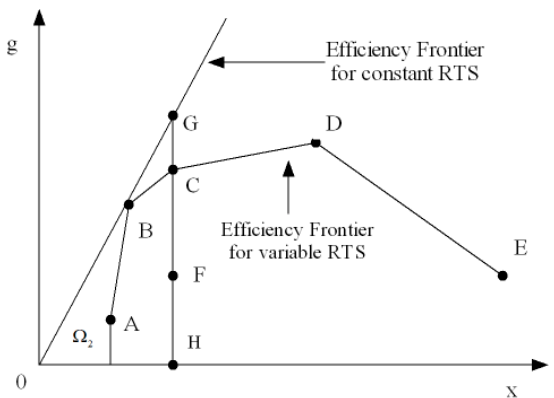
Figure 1. E ffi ciency frontier of the desirable outputs under constant RTS and variable Figure 1. Efficiency frontier of the desirable outputs under constant RTS and variable RTS.